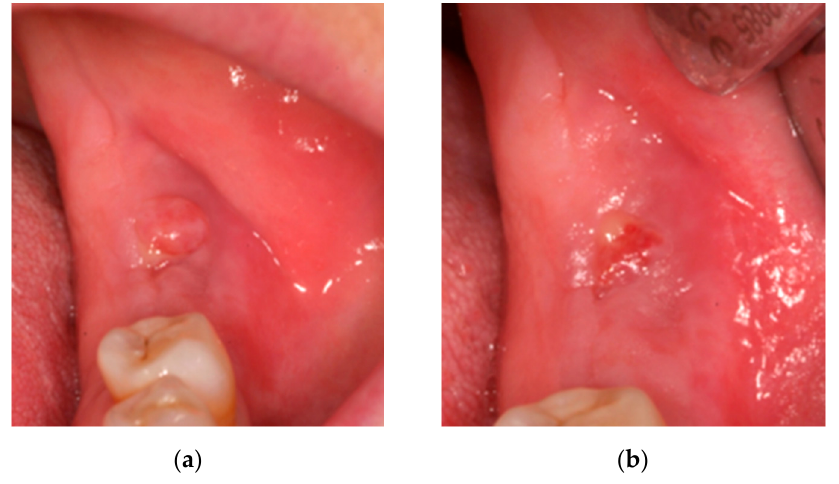
Figure 3. ( a ) Fistula in the jaw and ( b ) X-ray of the affected area. Immediate conservative treatment included amoxicillin/clavulanic acid (2000 mg + 125 mg every 12 h for 15 days) (Augmentin Plus, GSK, Madrid, Spain) and 0.12% chlor- hexidine rinses (Perio-Aid, Dentaid, Barcelona, Spain) every 12 h for 30 days. The rheu- matologist was consulted to discontinue bisphosphonates.